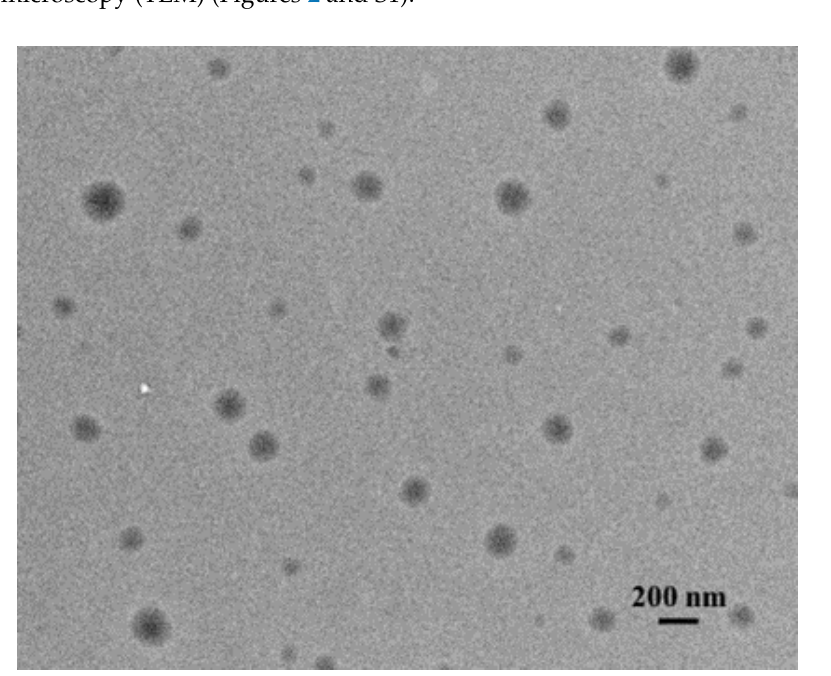
Table 1. Physicochemical properties of transfersomes, modified by C n PB at different molar ratio of